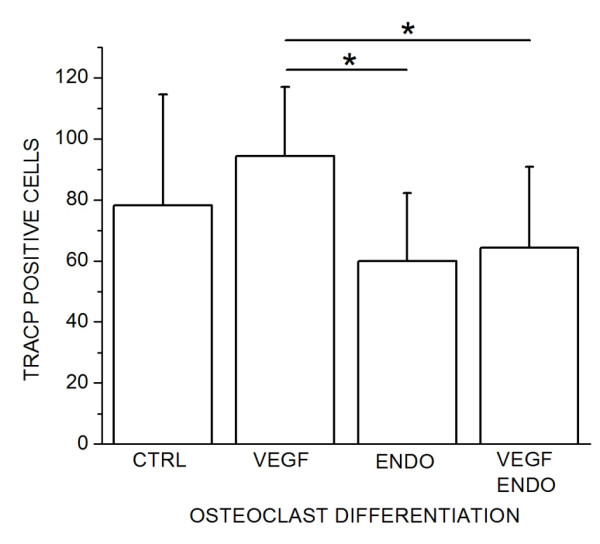
The number of TRACP+ multinuclear cells. Mouse (C57BL/6, 8–12 weeks) bone marrow cells were isolated from mouse long bones and seeded in 24-well plates on bovine bone slices. Cells on the bone slices were cultured in four groups: control, VEGF (100 ng/ml) and ENDO (2 μg/ml) and VEGF + ENDO respectively. The control group was cultured in α-MEM with 10% FCS containing 30 ng/ml RANKL and 10 ng/ml M-CSF for 7 days, after which the cultures were stopped by fixing the cells with 3% paraformaldehyde (PFA)/2% sucrose in PBS.